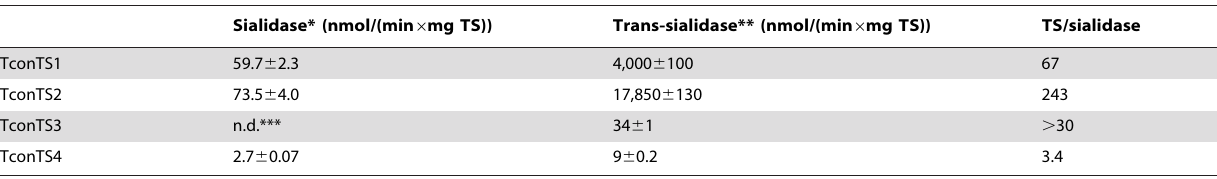
Table 4. Sialidase activities of